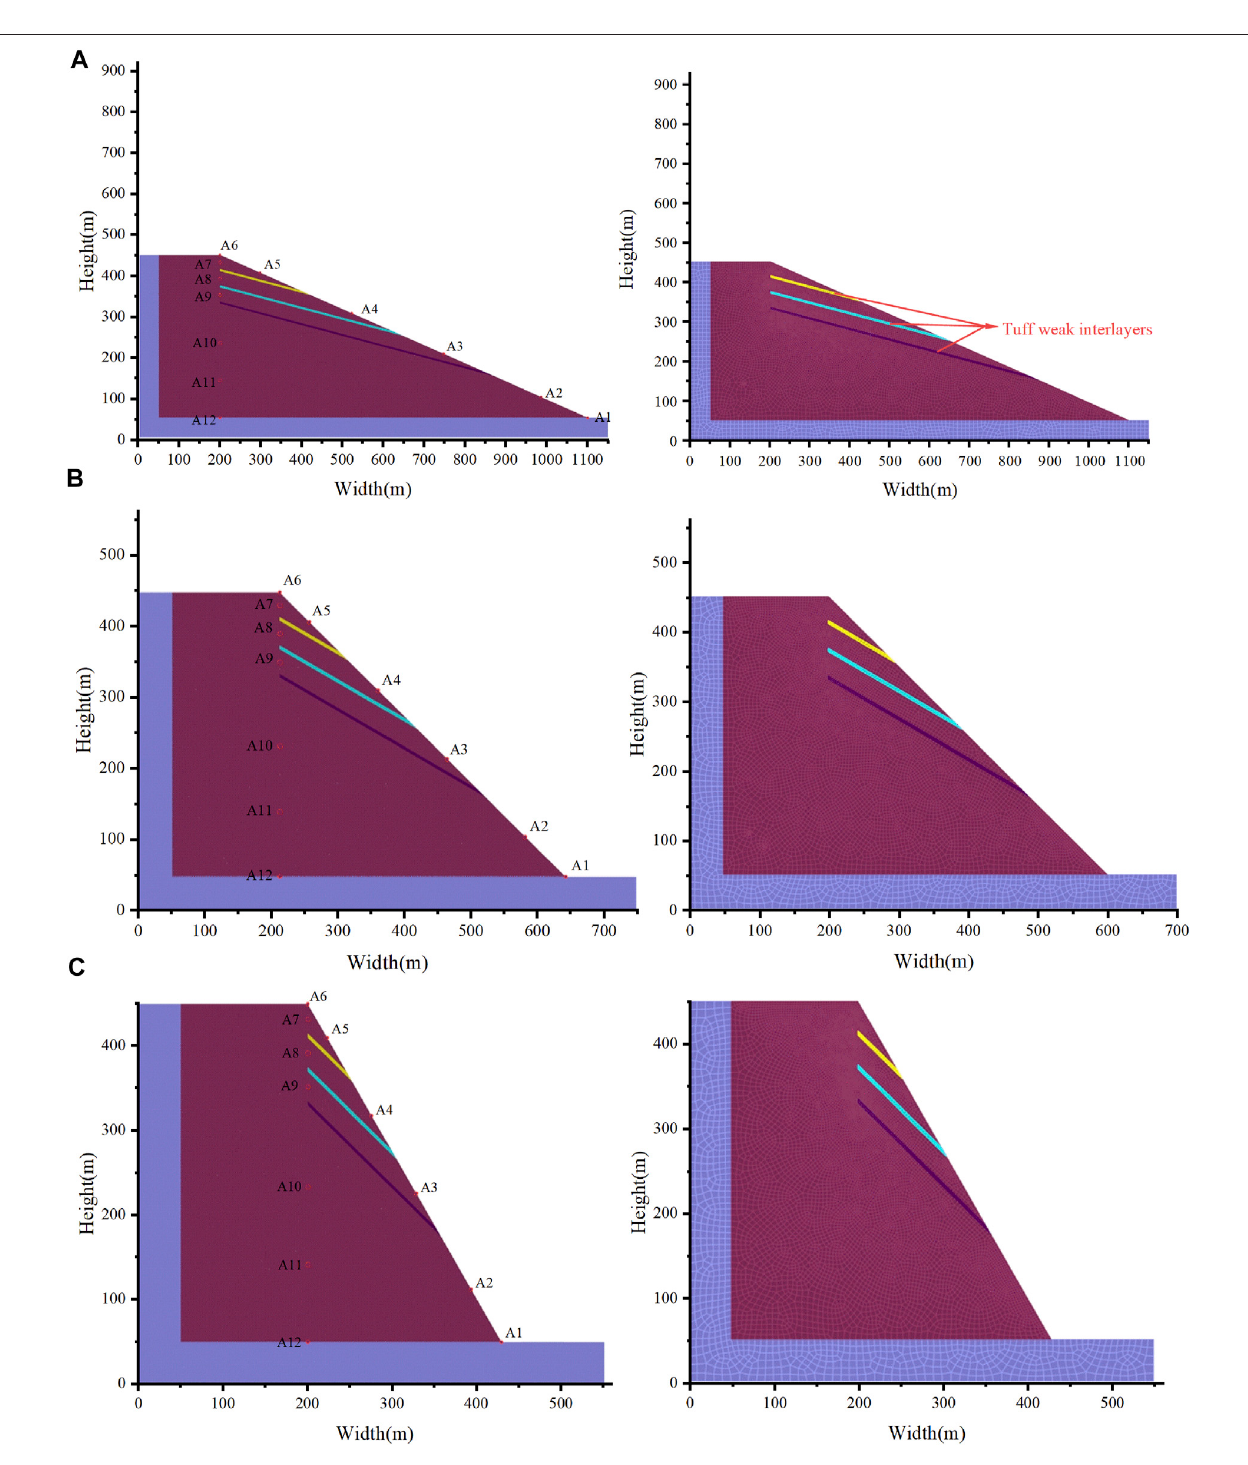
FIGURE 5 | Model geometry, monitoring point layout and grid division (A) weak interlayers dip is15 ° , (B) weak interlayers dip is30 ° , (C) weak interlayers dip is45 ° .